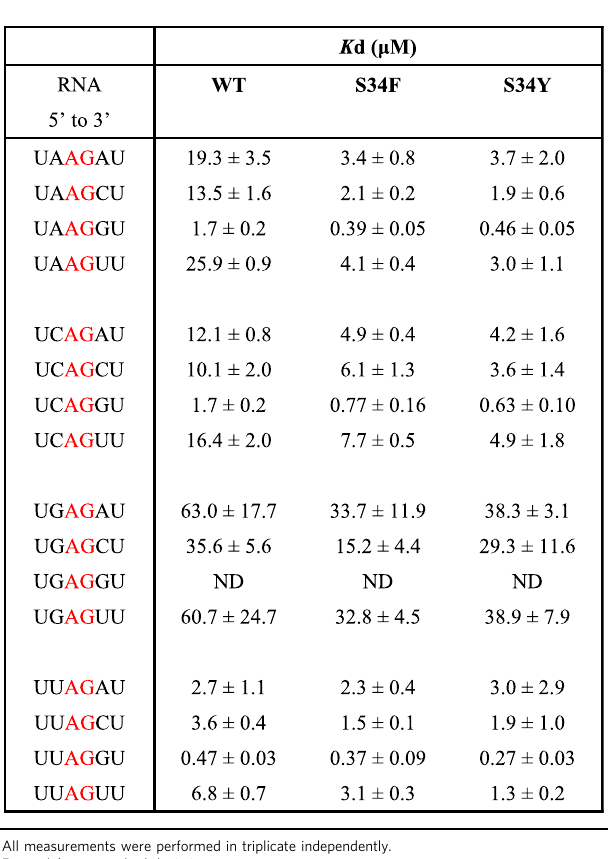
Table 1 RNA-binding activities to the U2AF1 evaluated by ITC